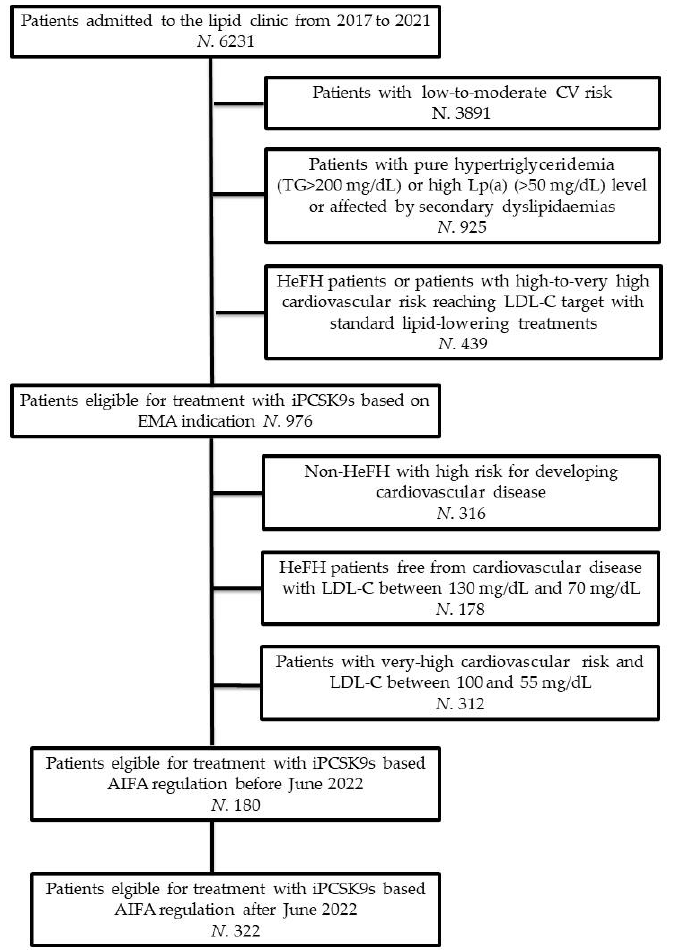
Figure 1. Flowchart of the study. AIFA = Italian Medicines Agency; EMA = European Medicines Agency; HeFH = Heterozygous familial hypercholesterolemia; iPCSK9s = Proprotein convertase subtilisin/kexin type 9 inhibitors; LDL-C = Low-density lipoprotein cholesterol; Lp(a) = Lipopro- tein(a). The remaining individuals (N. 986; Men: 475, Women: 511) were potential candidates for treatment with PCSK9 inhibitors. Based on national reimbursement rules issued by AIFA, 180 patients (Men: 88; Women: 92) were allowed access to treatment with PCSK9 inhibitors while 806 patients were not allowed. The reasons why these patients did not fulfill the prescription criteria for PCSK9 inhibitors were that they were non-He-FH hy- percholesterolemic individuals with high risk of developing CVD (N. 316), HeFH individ- uals free from CVD with LDL-C between 130 mg/dL and 70 mg/dL (N. 178) or patients with very high CV risk with LDL-C between 100 mg/dL and 55 mg/dL (N. 312). In a relevant percentage of cases, in patients who did not fulfill the prescription cri- teria for PCSK9 inhibitors the alternative therapeutic interventions provided the necessary